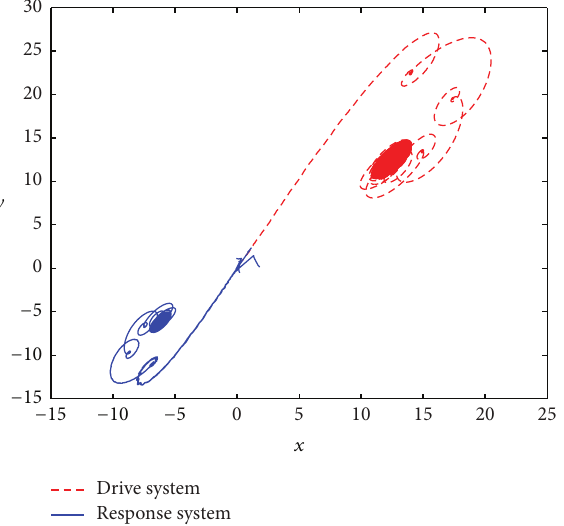
Figure 5: The phase plot of 𝑥 and 𝑦 plane with 𝛼 = −0.5 .